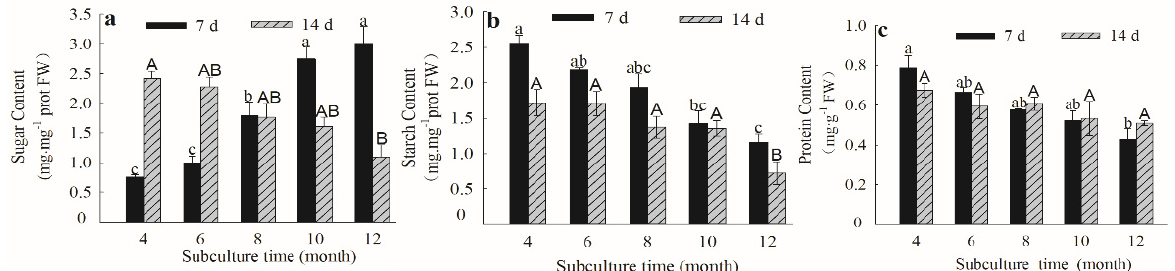
Figure 3. Effects of subculture cycle on storage substances in embryogenic calli of Pinus koraiensis during long-term subculture. ( a ) Sugar content of callus in different subculture cycles, ( b ) Starch content of callus in different subculture cycles, ( c ) Protein content of callus in different subculture cycles; Note: Different letters (upper or lower case) in the table indicate significant differences between columns (Duncan’s multiple range test; p = 0.05).